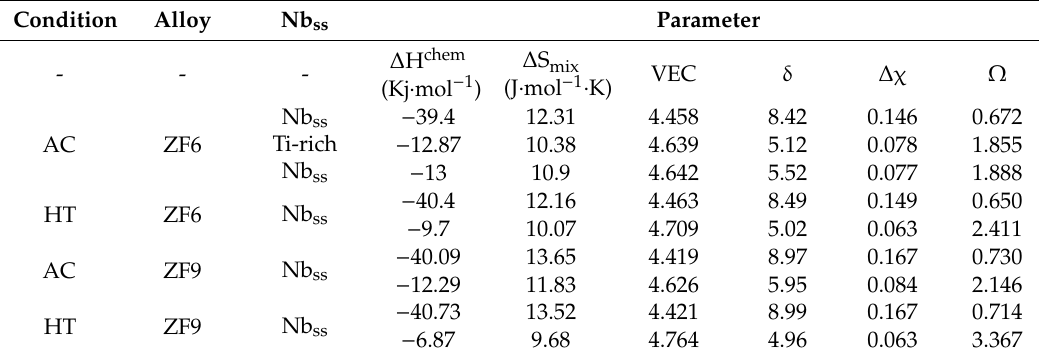
Table 10. The parameters ∆ H chem , ∆ S mix , VEC, δ , ∆ χ and Ω of the alloys ZF6 and ZF9 and their solid solutions in the as cast (AC) and heat treated (HT) conditions. For calculation of parameters see [35,36]. Note that the symbol Q was used instead of Ω in